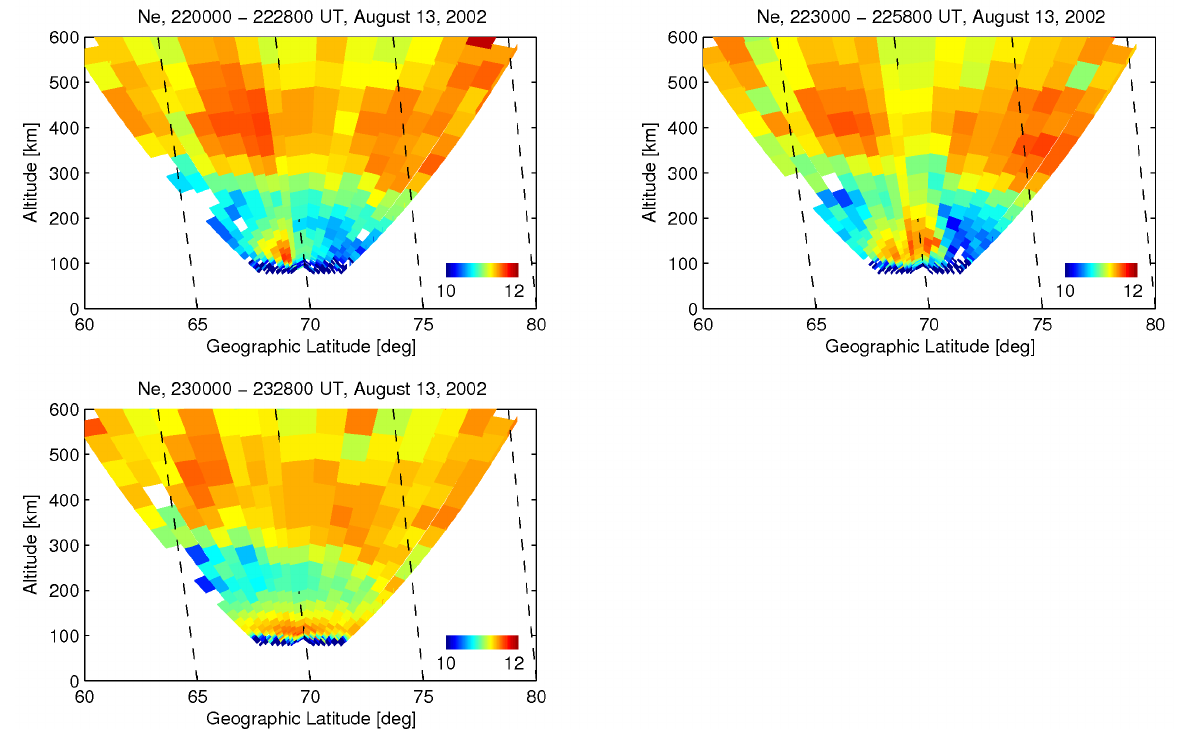
Fig. 6. EISCAT electron density data in log (m − 3 ) , as a function of geograhic latitude and altitude, for three consecutive scans from north to south (for the longitudes of the beam at 114km, see Fig.